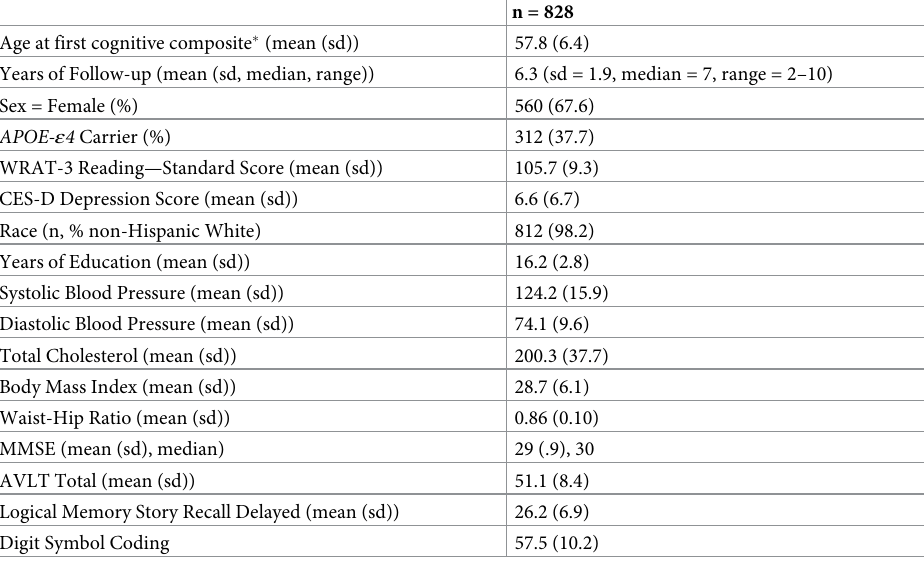
Table 2. Sample demographic and health characteristics at Wave 2 data